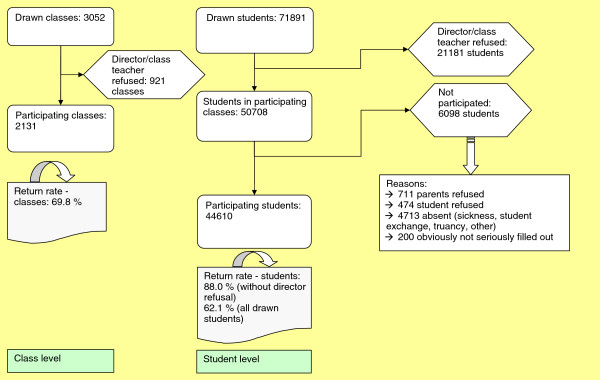
Sample constitution.